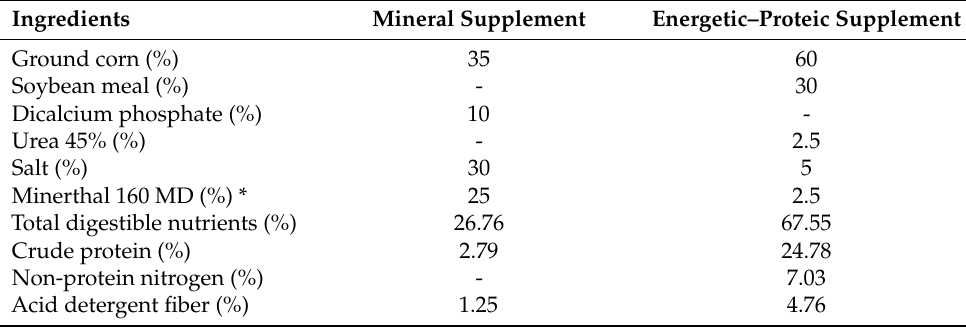
Table 1. Contents of ingredients and nutrients of supplement for